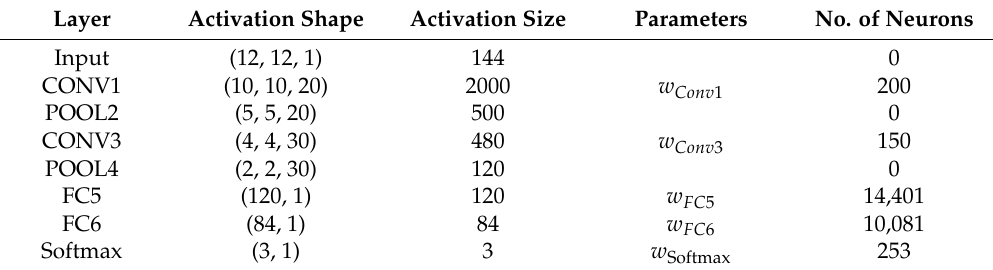
Table 8. The parameters of improve LeNet-5 structure. Table 5. The parameters of improve LeNet-5